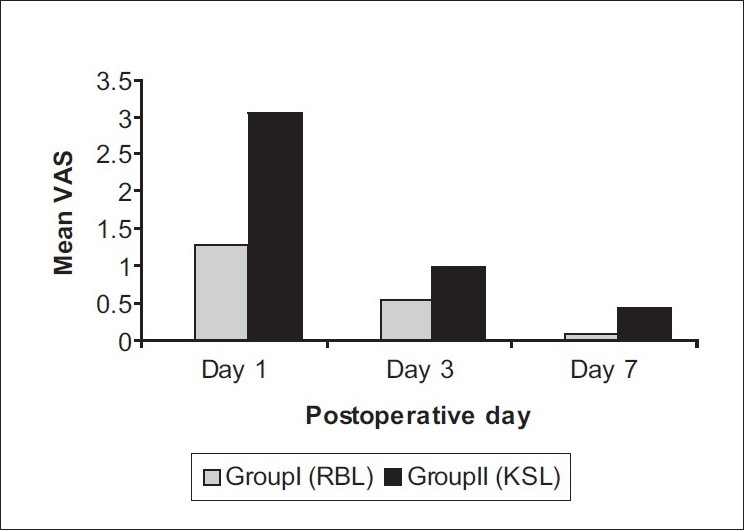
Postoperative Pain